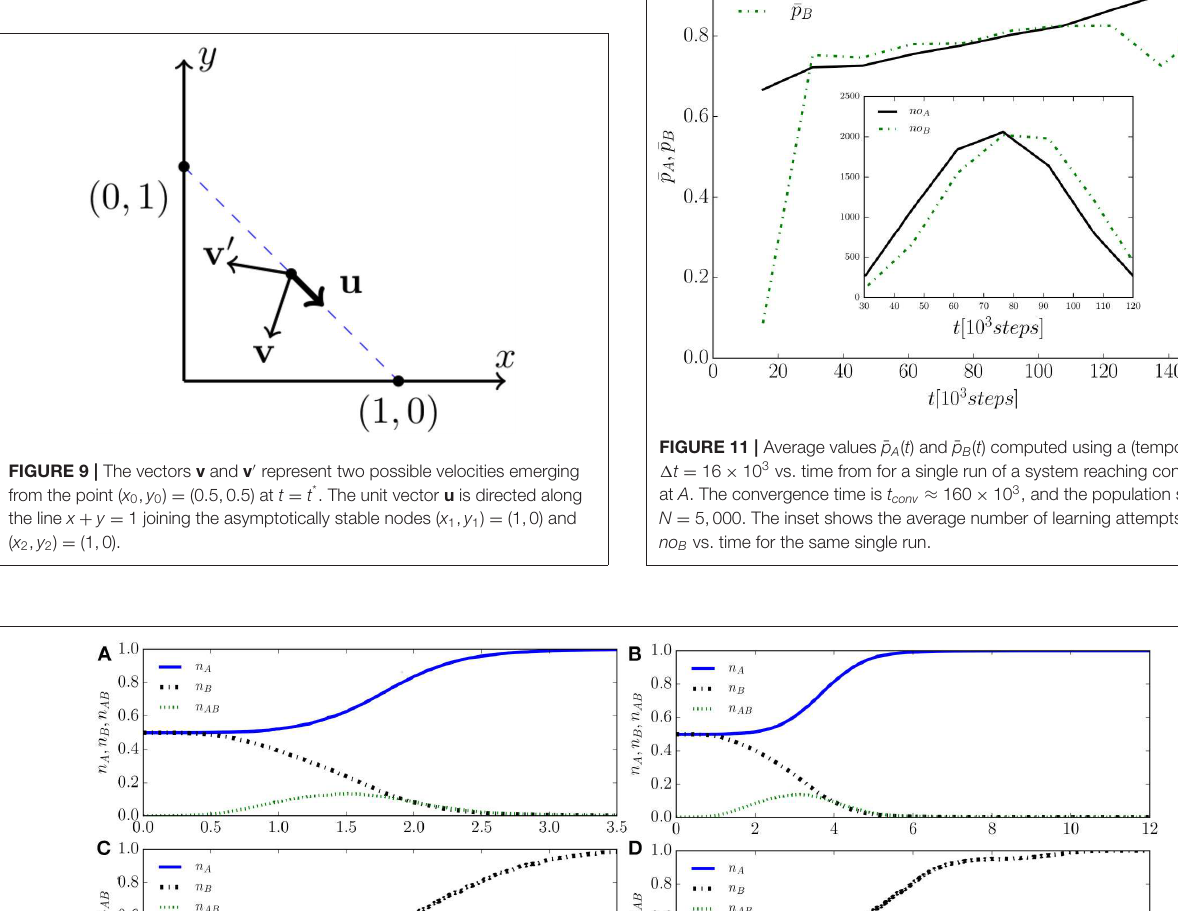
Frontiers in Physics |